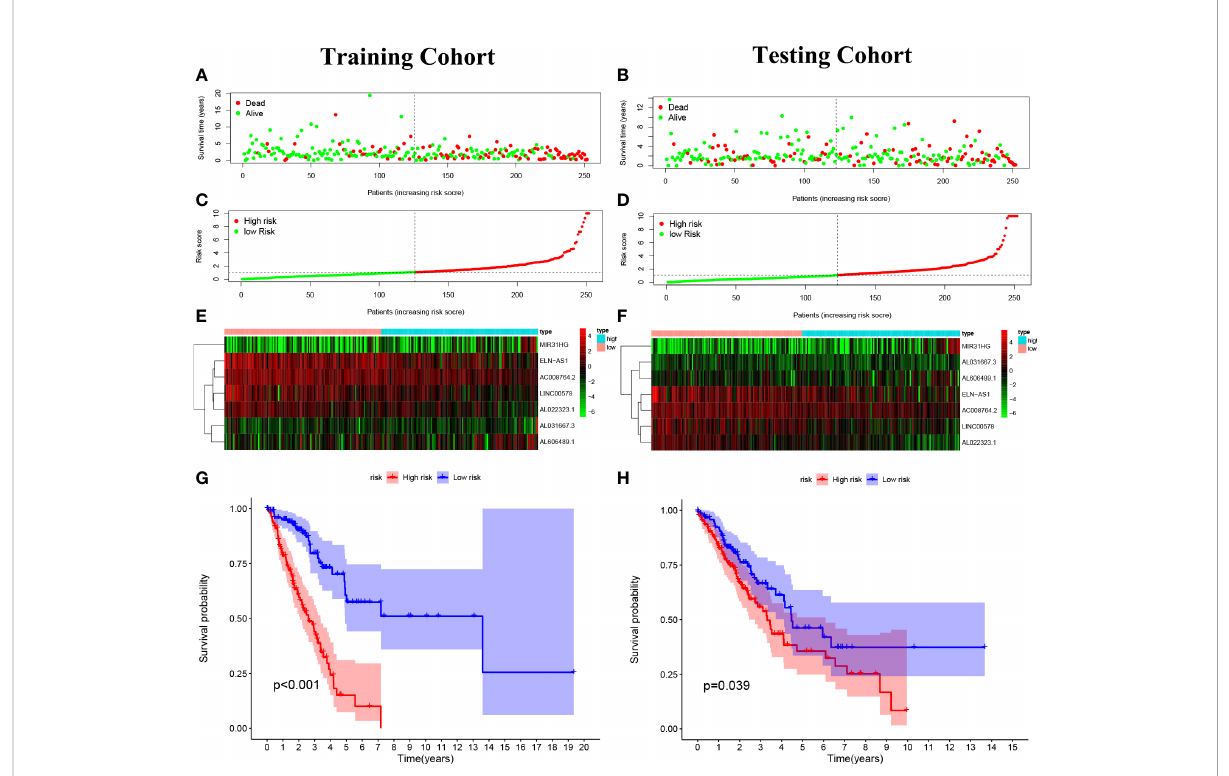
FIGURE 4 Construction of the predictive risk model in lung adenocarcinoma (LUAD) patients. (A, B) The risk score was calculated by 7 cuproptosis-related lncRNAs in the two cohorts (training and validation), and two risk groups were formed in LUAD patients. Green, low risk; red, high risk. (C, D) Survival status of LUAD patients. Green: survival; red: death. (E, F) The heat map indicates the expression degrees of 7 cuproptosis-related lncRNAs. (G, H) The Kaplan – Meier analysis revealed the overall survival in the two risk